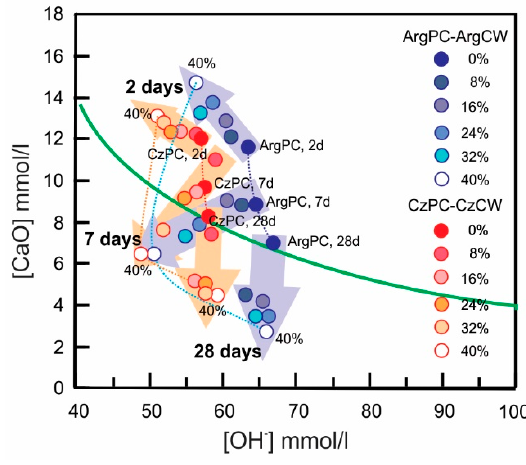
Figure 5. Results of Frattini test on day 2, 7, and 28.